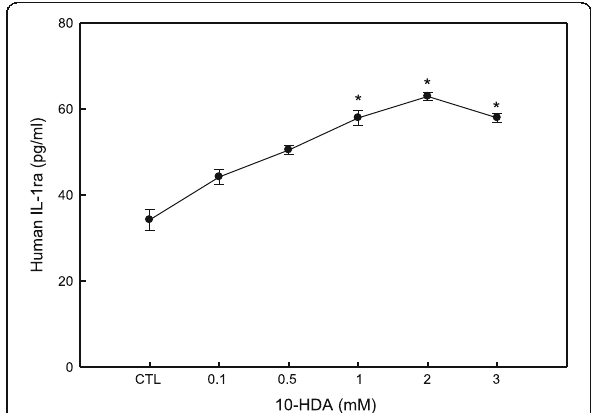
Fig. 4 Effect of 10-HDA on human IL-1ra production in WiDr cells. Supernatants of WiDr cultures, treated with or without 10-HDA (0.1, 0.5, 1, 2, 3, and 5 mM), were collected after 24 h and tested by ELISA for detecting IL-1ra. CTL represents the control group (without 10- HDA). Each point is a mean ± SD of the triplicates from one representative experiment. * = p ≤ 0.05 compared to